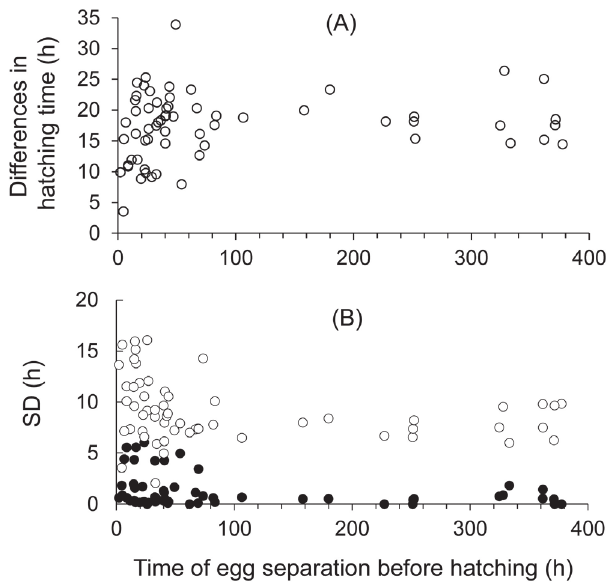
Fig. 7. The effect of the time of separation of Locusta migratoria eggs on the hatching time. The differences in mean hatching times be- tween eggs separated and those kept in contact with each other (con- trols) are plotted against the time of egg separation gauged based on the mean hatching time for the control eggs ( A ). SDs of the mean hatching times are plotted against the time of egg separation gauged based on the mean hatching time for the control eggs kept in masses ( B ). Open and closed circles indicate eggs separated and those kept in masses, respectively. Each datum point is based on 16–20 eggs.